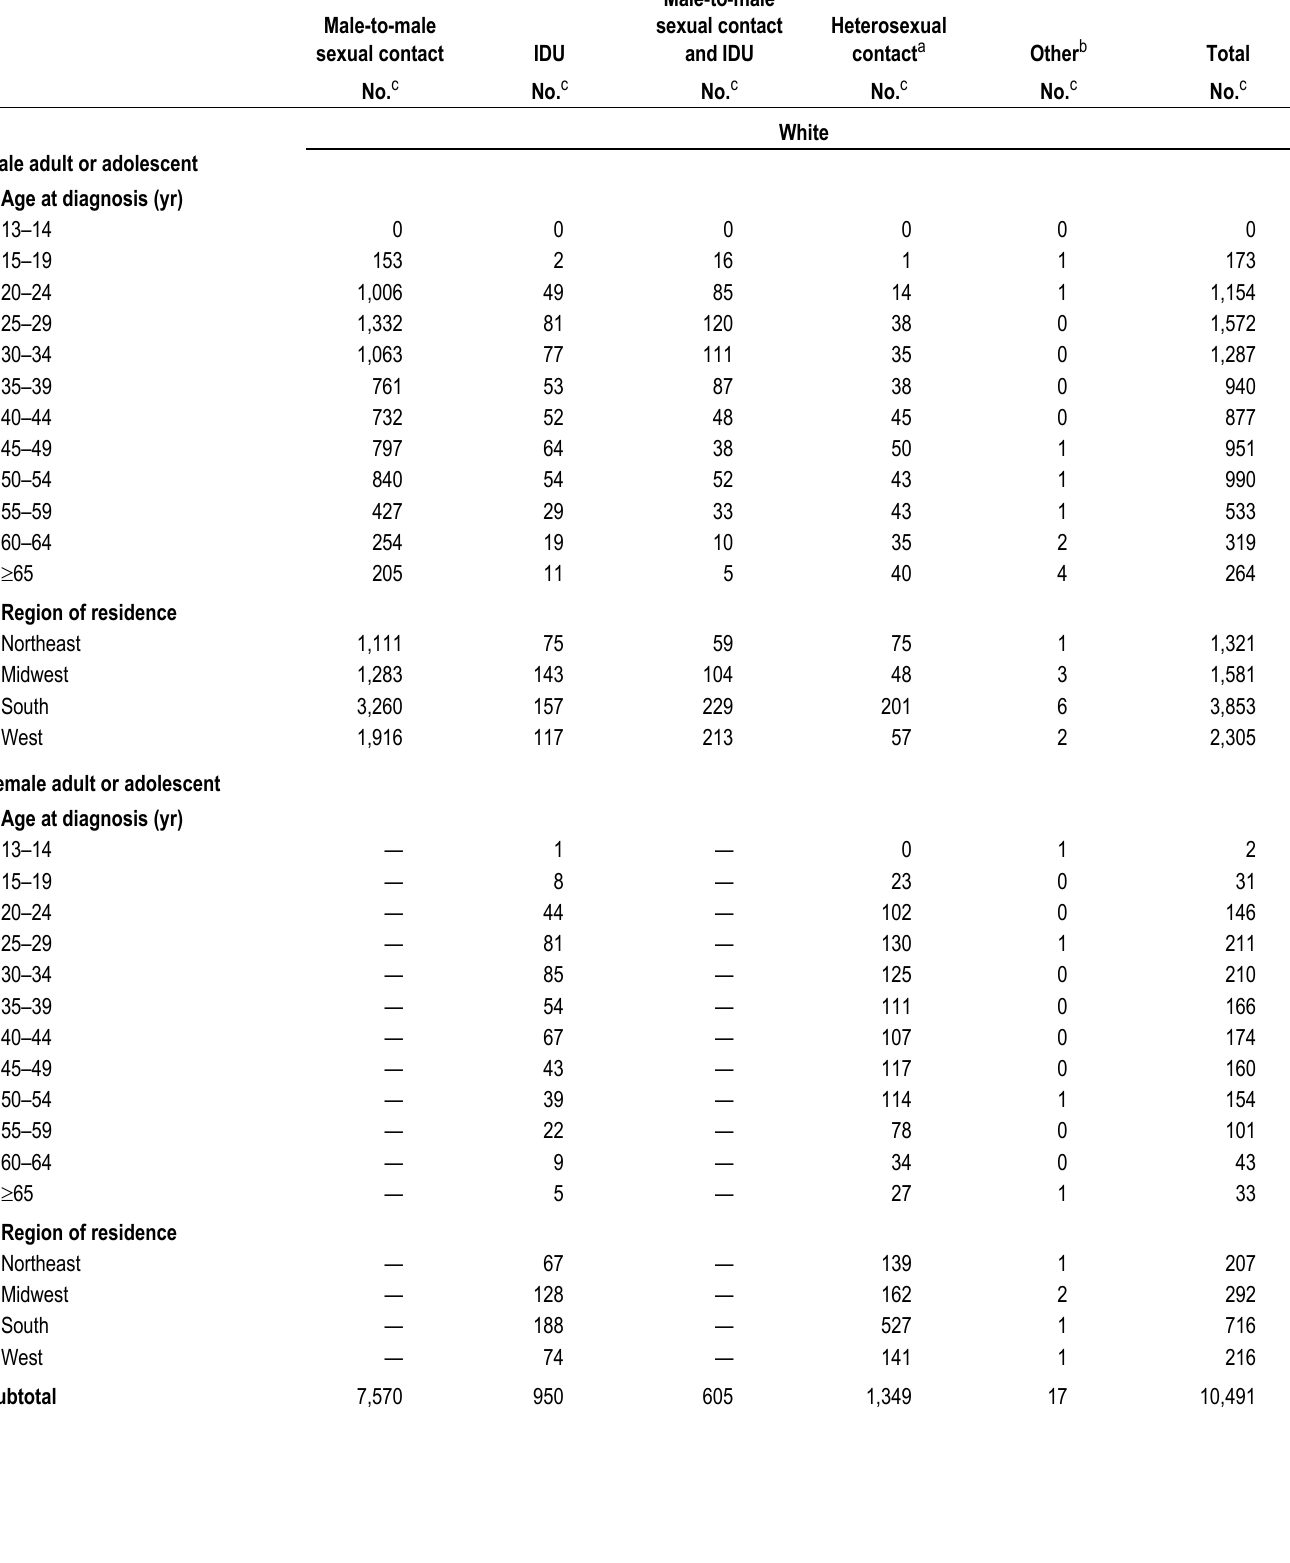
Table 5a. Diagnoses of HIV infection, by transmission category, race/ethnicity, and selected characteristics, 2015—United States